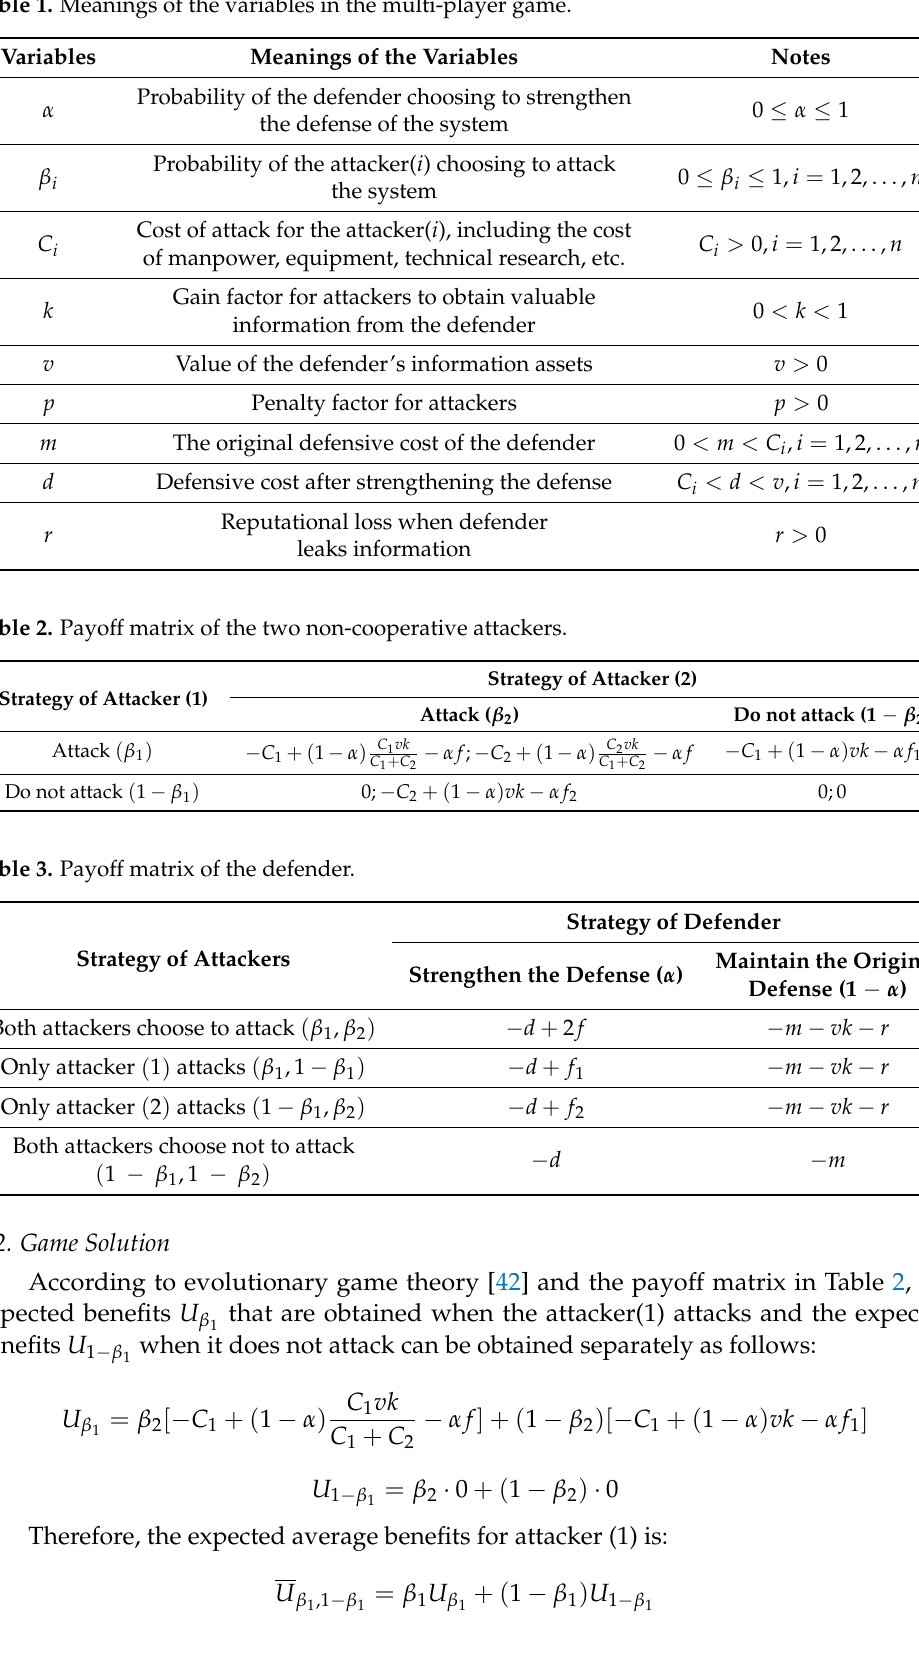
Table 1. Meanings of the variables in the multi-player game.